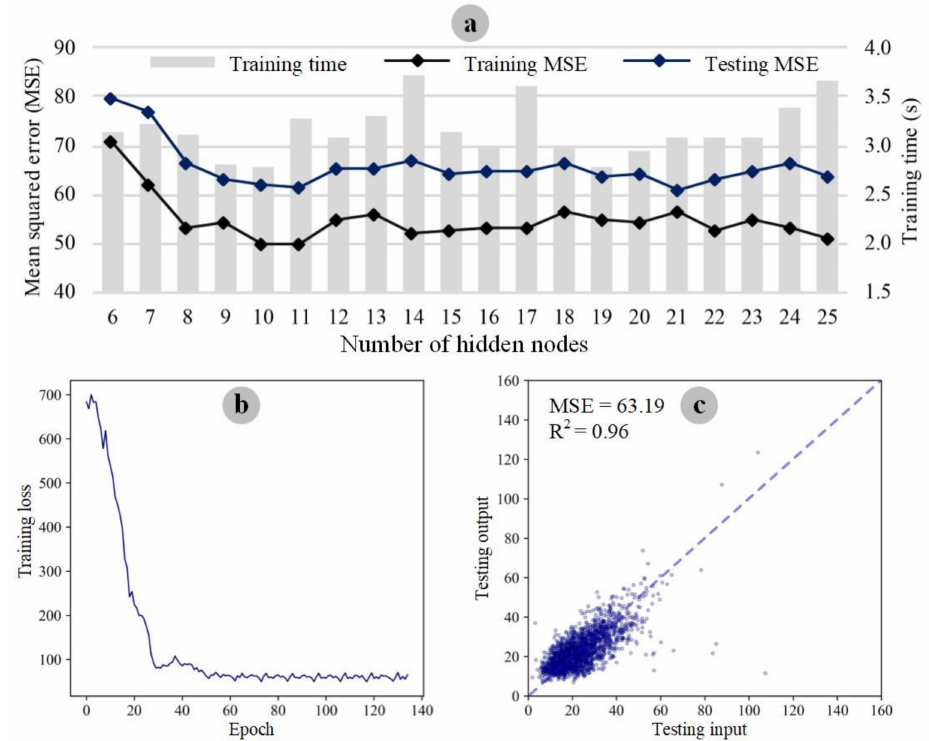
Figure 7. The performance of the BPNN model. ( a ) The performance of the model with different number of hidden nodes; ( b ) The training loss of the 25-10-1 network; ( c ) The testing of the 25-10- 1